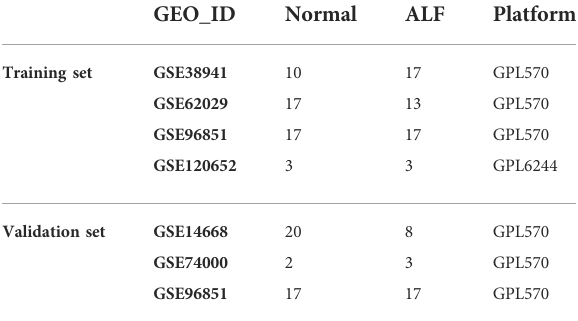
TABLE 1 The samples from 7 datasets included in the